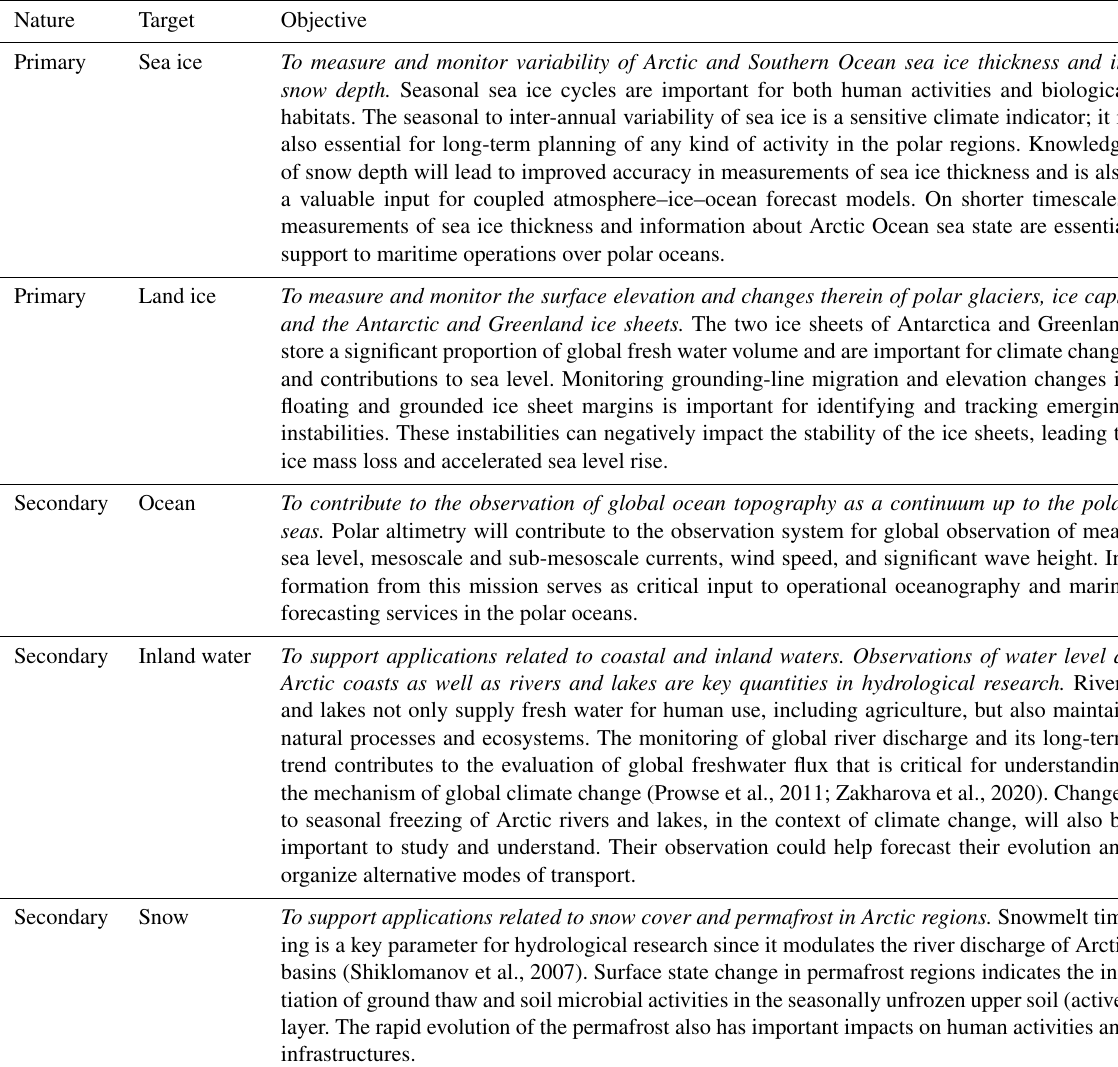
Table 1. CRISTAL mission